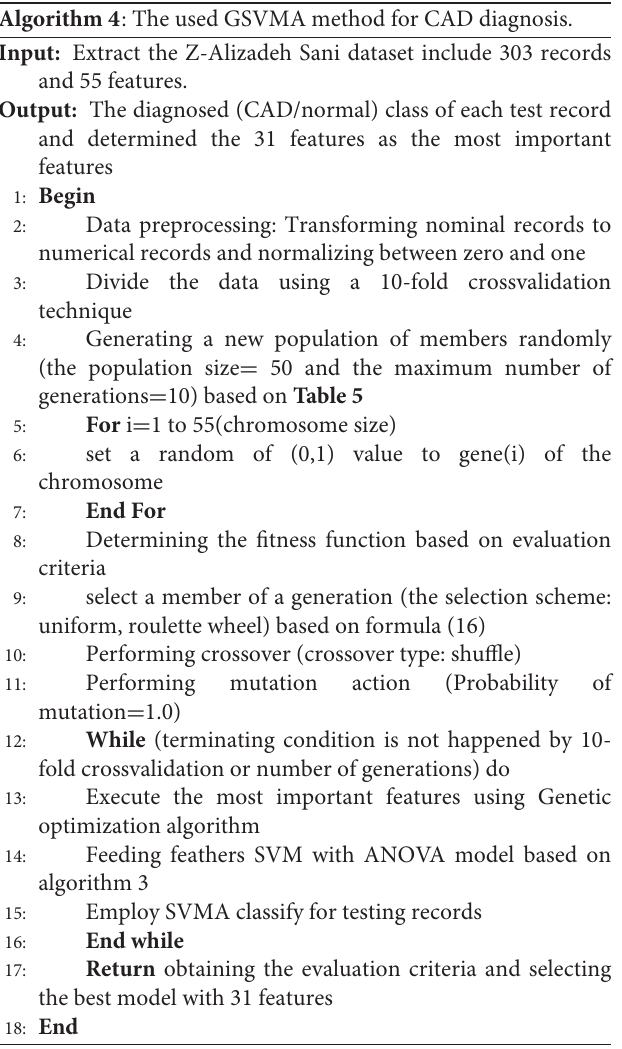
Algorithm 4 : The used GSVMA method for CAD diagnosis.